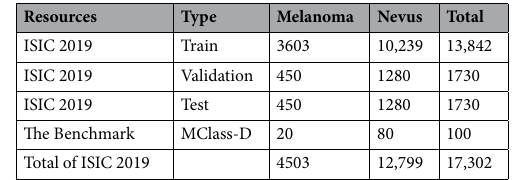
Table 3. Melanoma train, validation, test, and benchmark